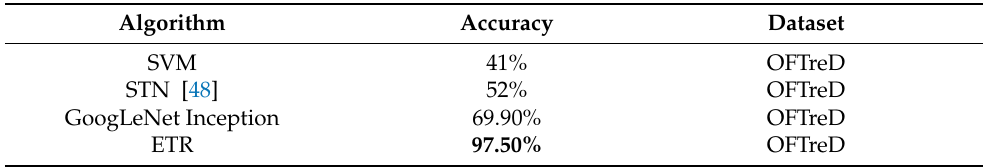
Table 5. Classification accuracy compared with other